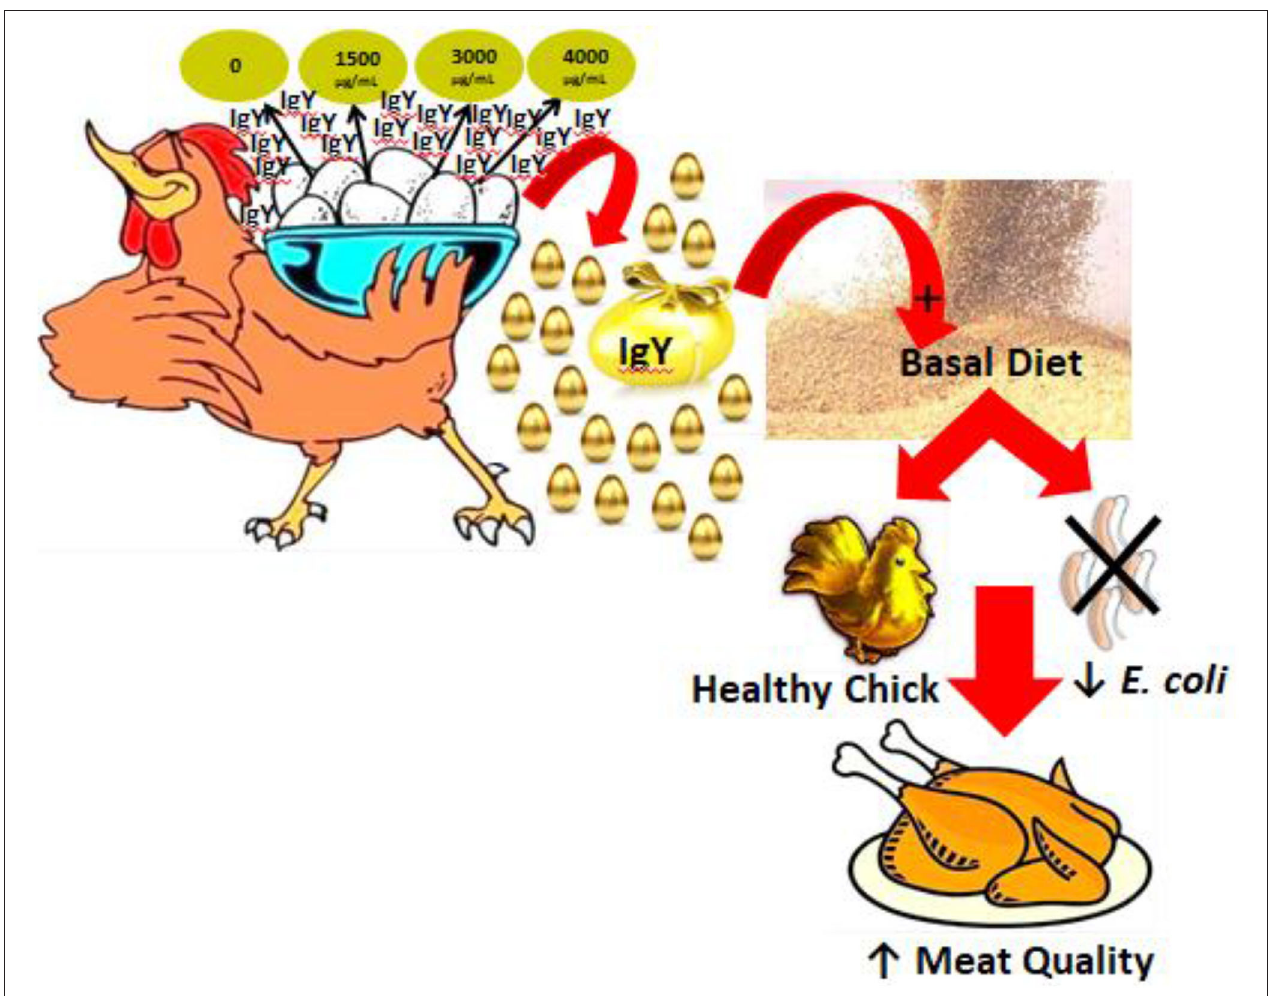
FIGURE 1 | Schematic cartoon of the study strategy designed using Biorender.com.